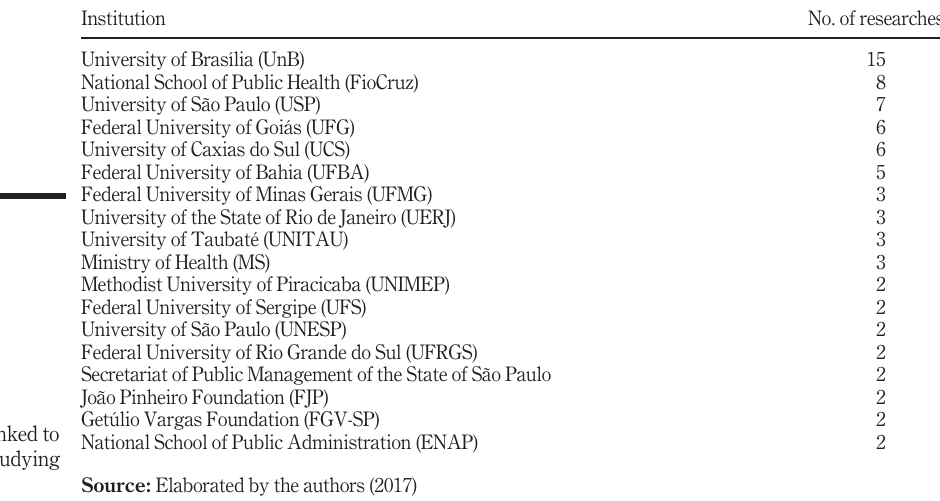
Table IV. Institutions linked